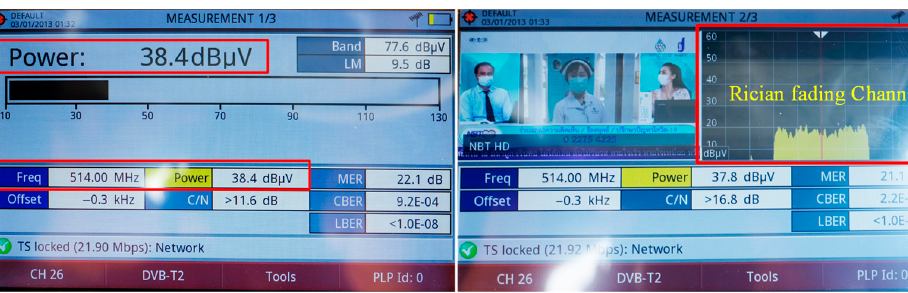
Figure 22. The outdoor reception performance of the portable wideband directional antenna scheme.